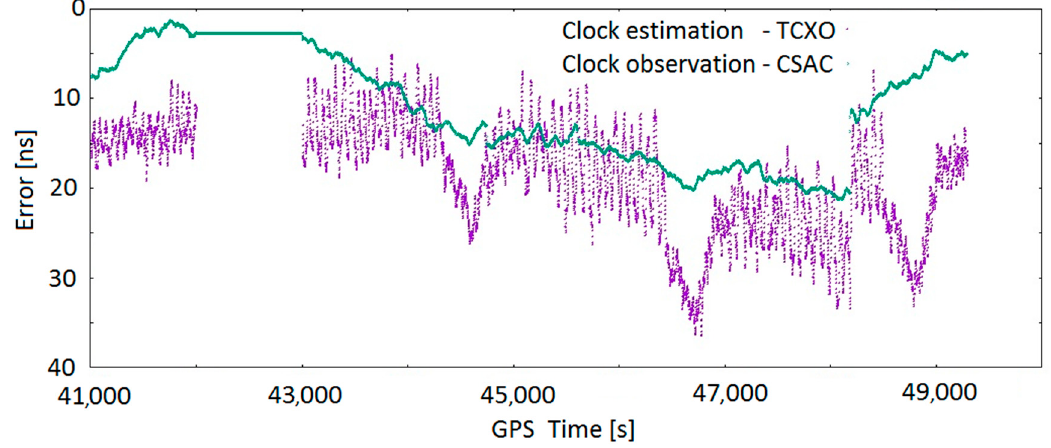
Figure 15. TCXO clock correction estimation and CSAC clock correction observation.